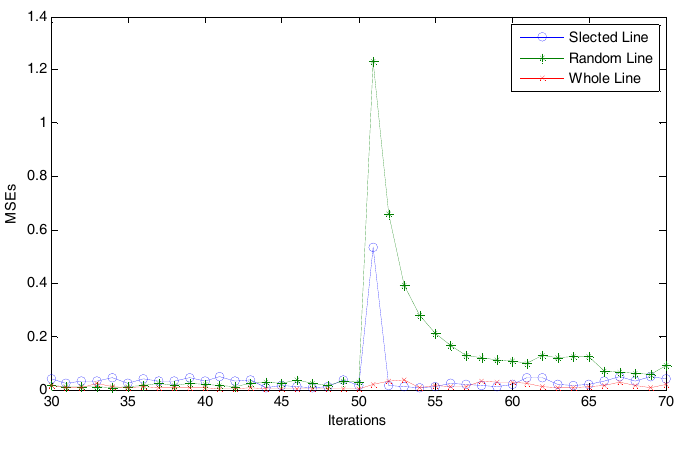
Figure 2. Three MSE lines.